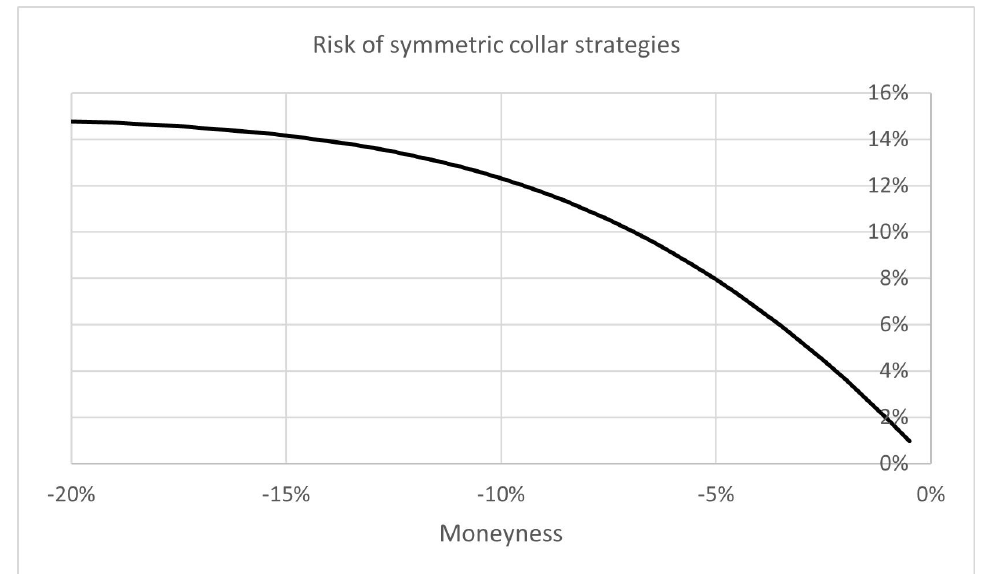
Figure 16. The risk of the return of an underlying asset with an overlaid symmetric collar strategy for a range of strike prices.